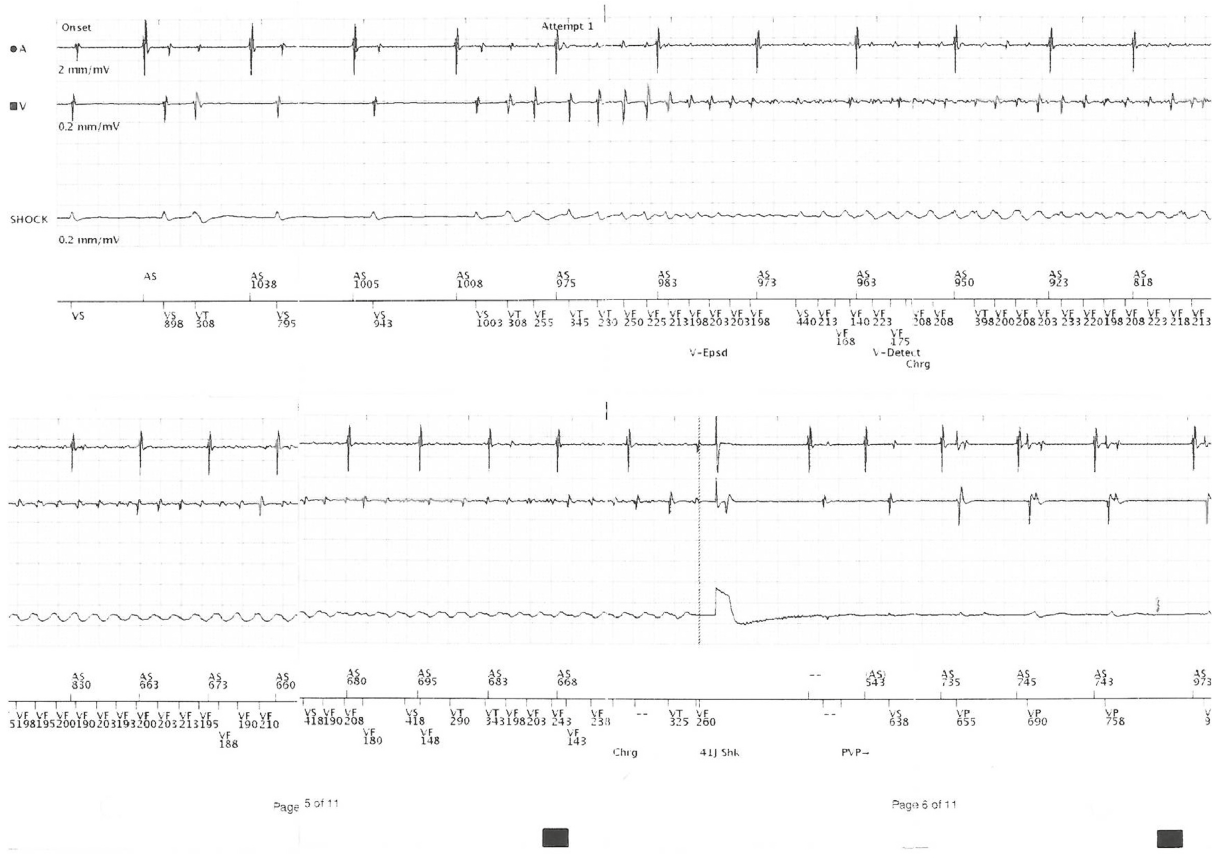
Figure 3: Interrogation of the dual-chamber defibrillator revealing an episode of ventricular fibrillation, followed by a